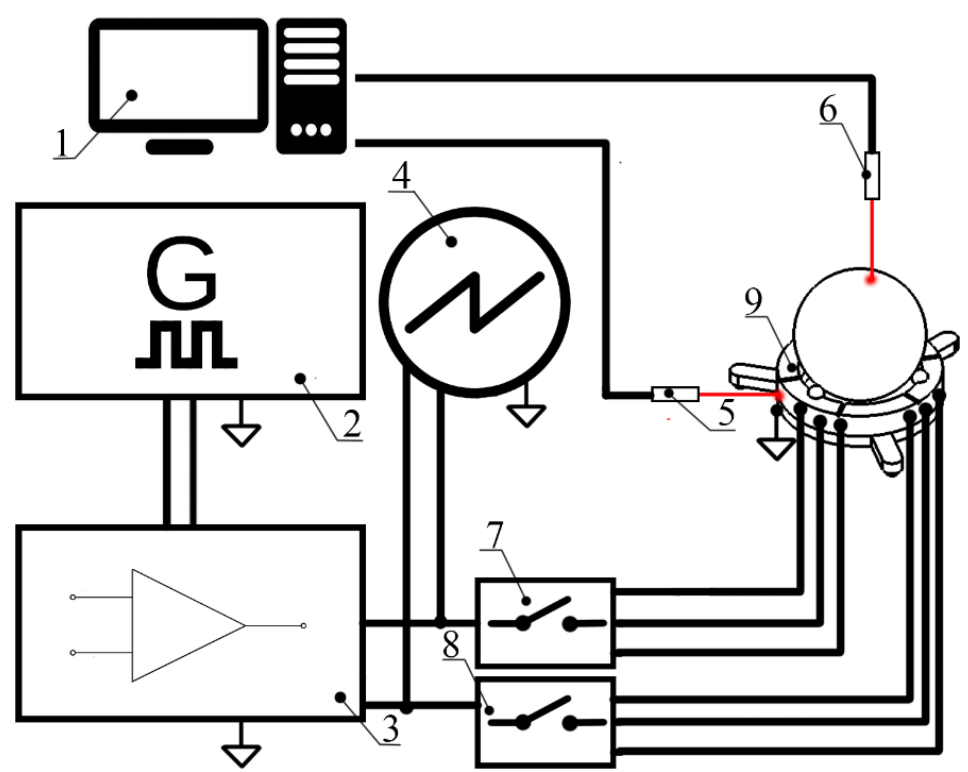
Figure 15. Schematics of the experimental setup; 1—computer; 2—signal generator with two inde- pendent channels; 3—power amplifier; 4—oscilloscope; 5—laser displacement sensor for planar motion measurements; 6— tachometer for angular motion measurements; 7—switch box for planar motion control; 8—switch box for angular motion control; 9—the prototype of